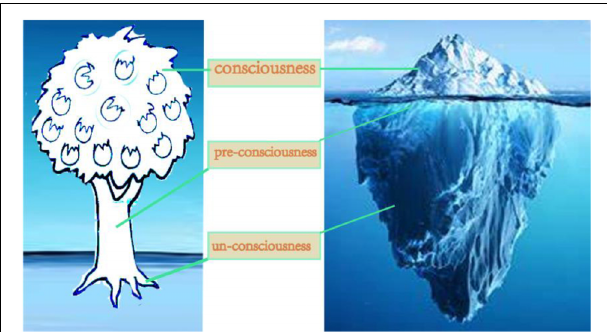
FIGURE 7 | Hypothesis about the representation of a tree-drawing with the consciousness.